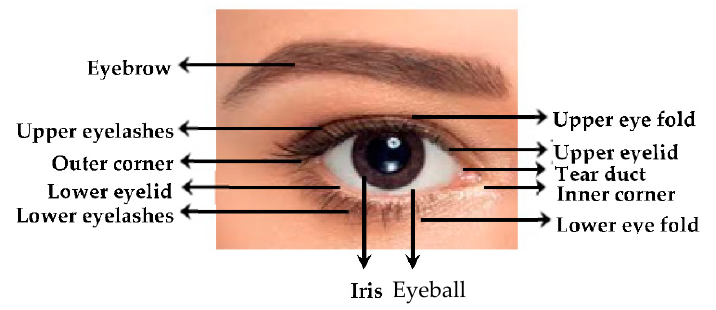
Figure 1. Examples of some cases in which using periocular biometrics is efficient.